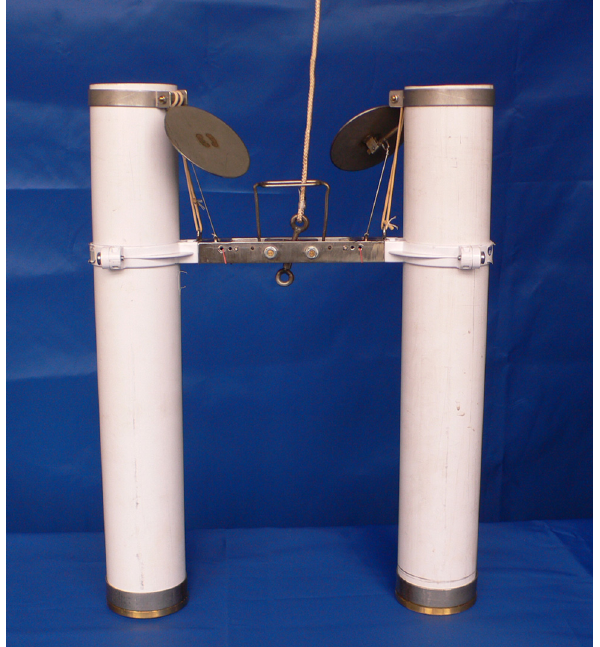
Fig 1. Photo of the sediment